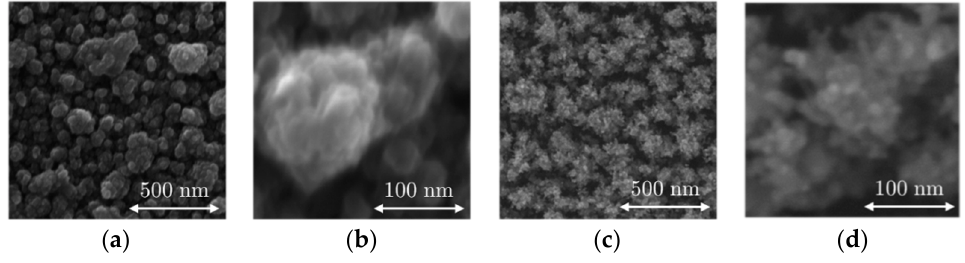
Figure 2. SEM images of black aluminum (B-Al) ( a ) 100 kx, ( b ) 500 kx, and black gold (B-Au) ( c ) 100 kx, ( d ) 500 kx.